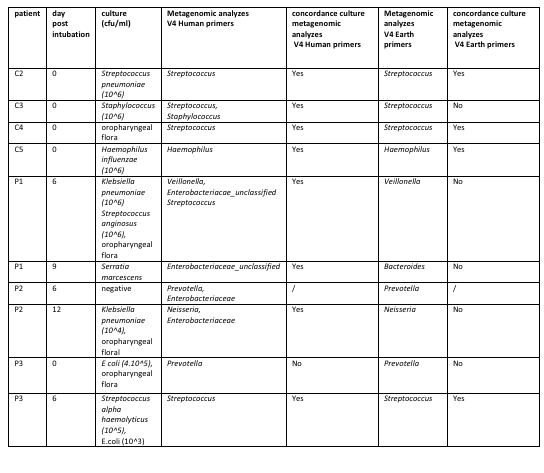
Table 1 Comparison between NGS and culture results for endotra‑ cheal aspirates